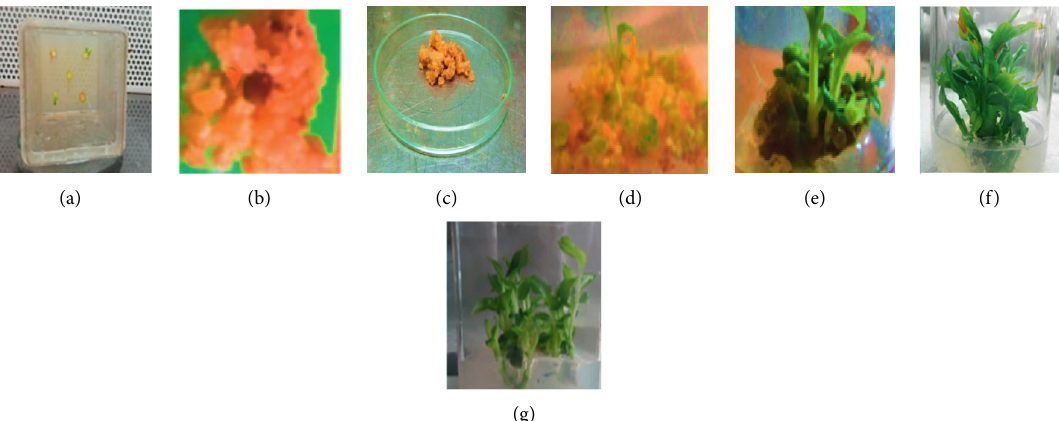
Figure 2: In vitro regeneration of korarima: (a) rhizomes cultured on callus induction media; (b) friable callus produced on the MS medium containing 3.0 mg/l 2,4-D combined with 0.5mg/l KN after 10 weeks; (c) friable callus ready for shoot regeneration; (d) shoots developed from callus on shoot induction MS medium containing 2.0mg/l TDZ combined with 0.5mg/l IBA after two weeks; (e) shoots regenerated on 2.0mg/l TDZ combined with 0.5mg/l IBA after four weeks; (f) shoots proliferated after the transfer of shoot tips on 2.0 mg/l TDZ combined with 0.5mg/l IBA; (g) shoots proliferated after the transfer of shoot tips on 2.0 mg/l BAP combined with 0.5mg/l IBA. Bars � 1cm. Table 4: Effect of 2, 4-D, KN, and NAA on in vitro callus induction of korarima. 2,4-D (mg/l)